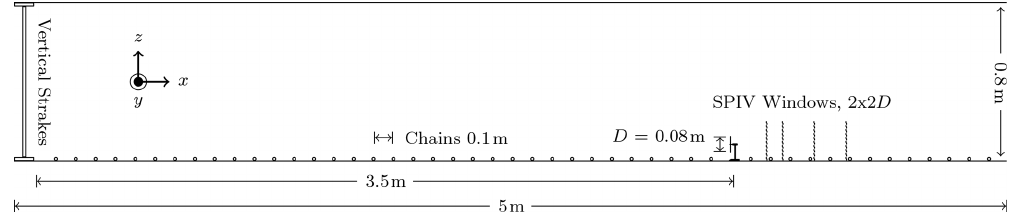
Figure 1. Portland State University wind tunnel with experimental apparatus and measurement locations to scale. Chains are shown at 2 × scale to enhance visibility. All dimensions in meters unless otherwise noted.